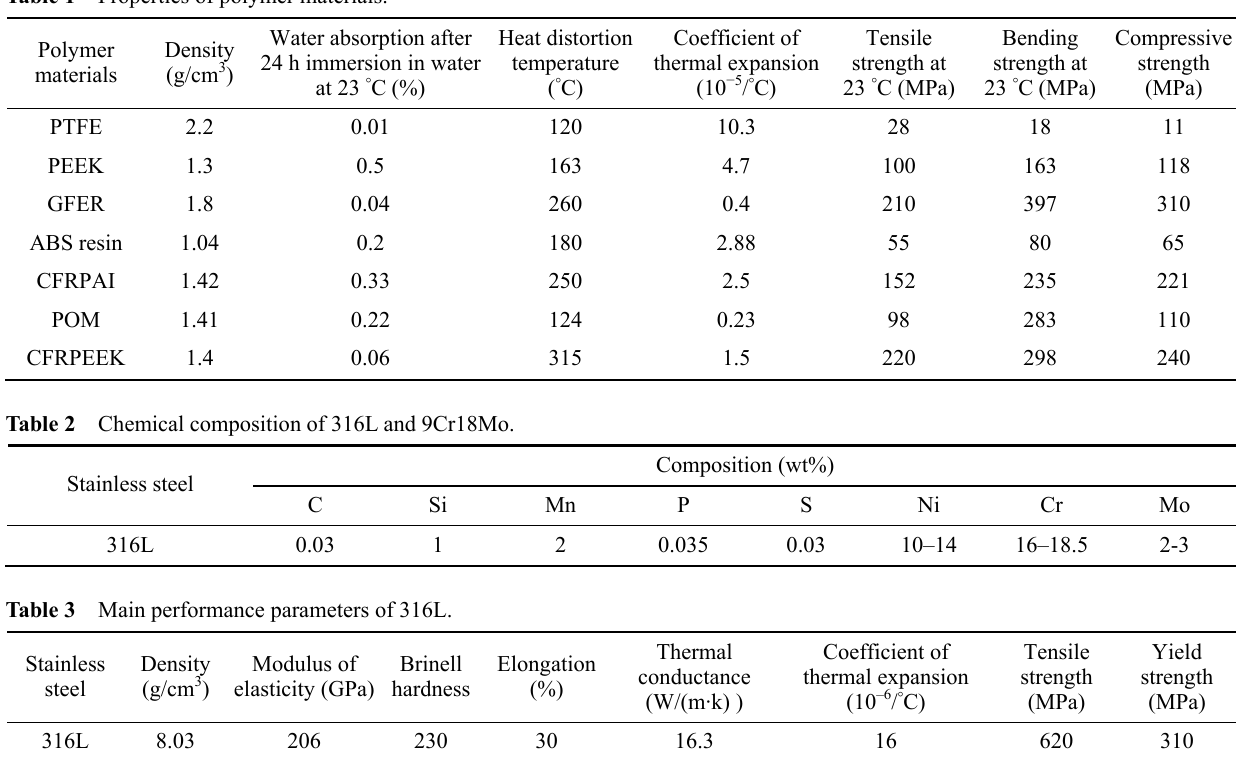
Table 1 Properties of polymer materials.